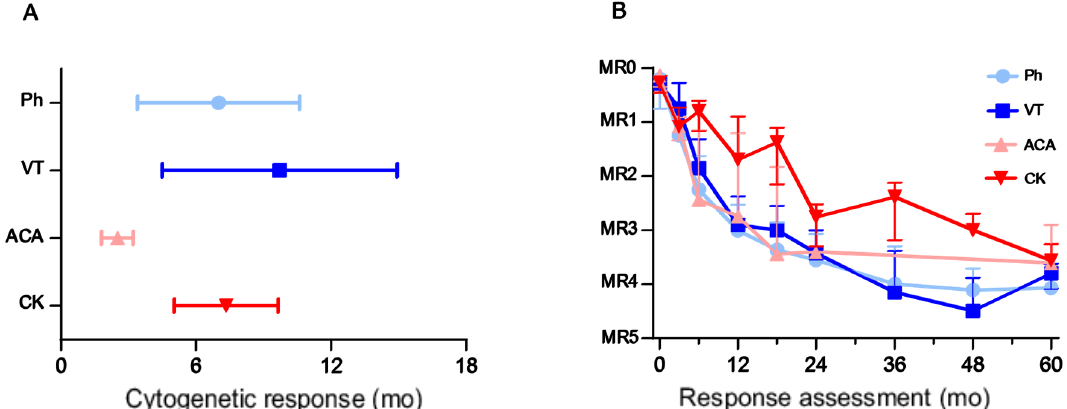
Figure 2. ( A ) Time point of cytogenetic response in patients carrying only the BCR::ABL1 translocation (Ph) compared to patients with variant translocations (VT), additional chromosomal aberrations (ACA) and complex karyotype (CK). ( B ) Initial BCR::ABL1 transcript level and treatment response over time in patients carrying only the BCR::ABL1 translocation (Ph) compared to patients with variant translocations (VT), additional chromosomal aberrations (ACA) and complex karyotype (CK).